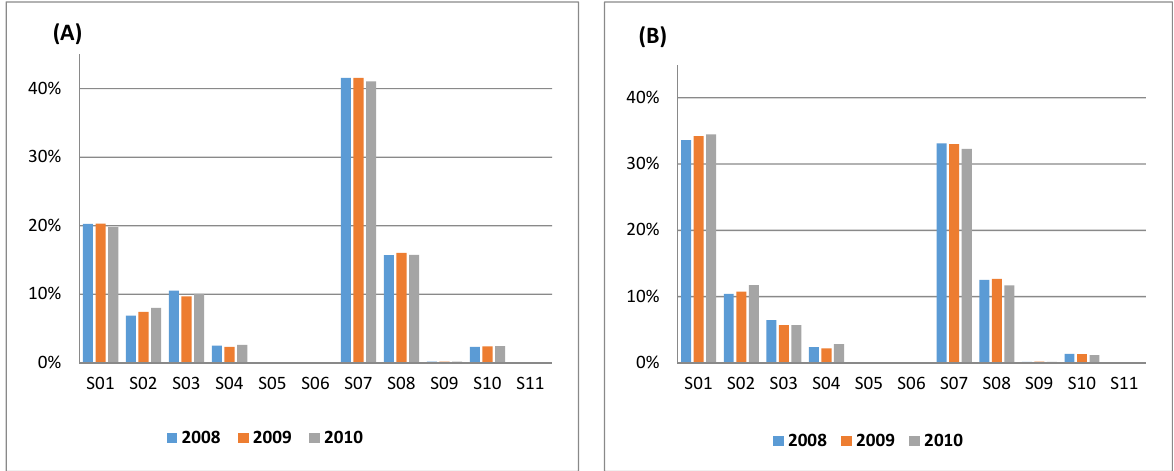
Figure 2. Emissions of nitrogen oxides NOx as NO 2 for EU28 ( A ) and Poland ( B ) divided into different SNAP97 sectors, based on the EMEP database for the period 2008–2010.